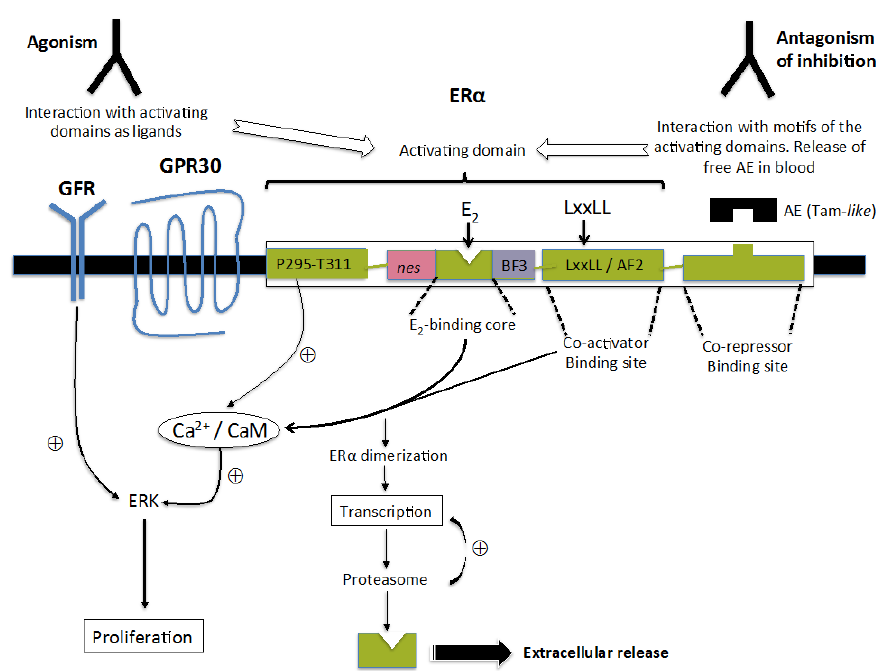
Figure 2. Schematic representation of ER α ABs-induced mechanisms initiated at the plasma membrane to promote enhanced proliferation and ERE-dependent transcription. Reported ER α AB activities (agonism, antagonism of inhibition) were integrated in a classical model explaining co-operation between binding sites for growth factors and steroid hormones in the onset of non-genomic and genomic responses [11,12,14,27,33,37,38]. Note the pivotal role of the Ca 2+ /calmodulin complex in the inter-relationships between GPR30 and recruitment sites of the receptor for ER α ABs and adjacent co-activators. AE: antiestrogen; Tam-like: Tamoxifen-like.